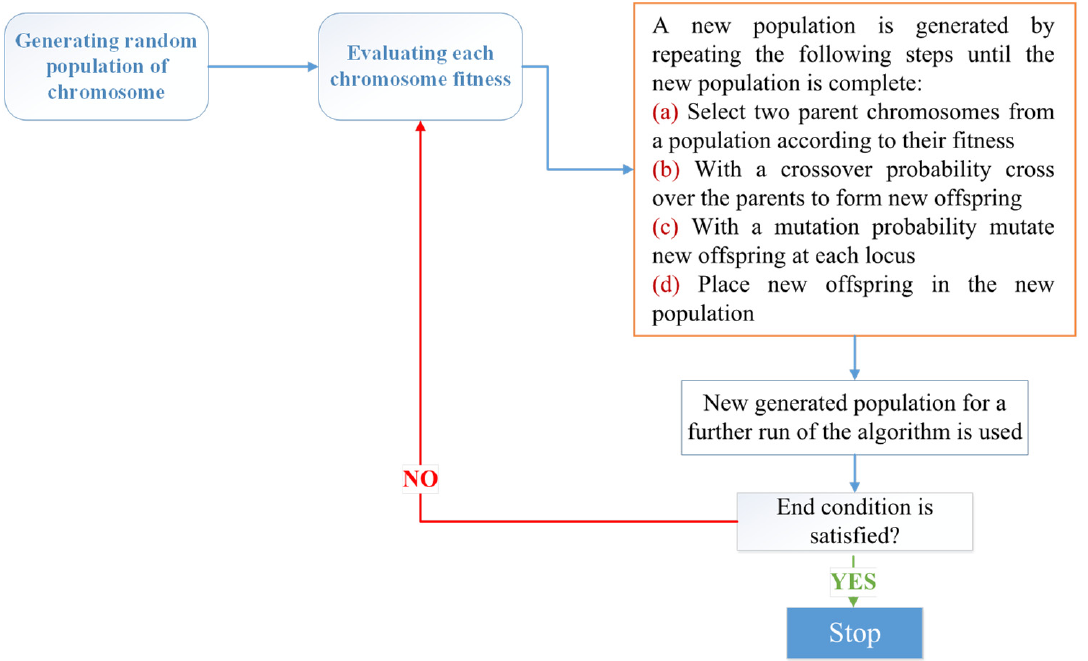
Figure 7. The design structure of the genetic algorithm.